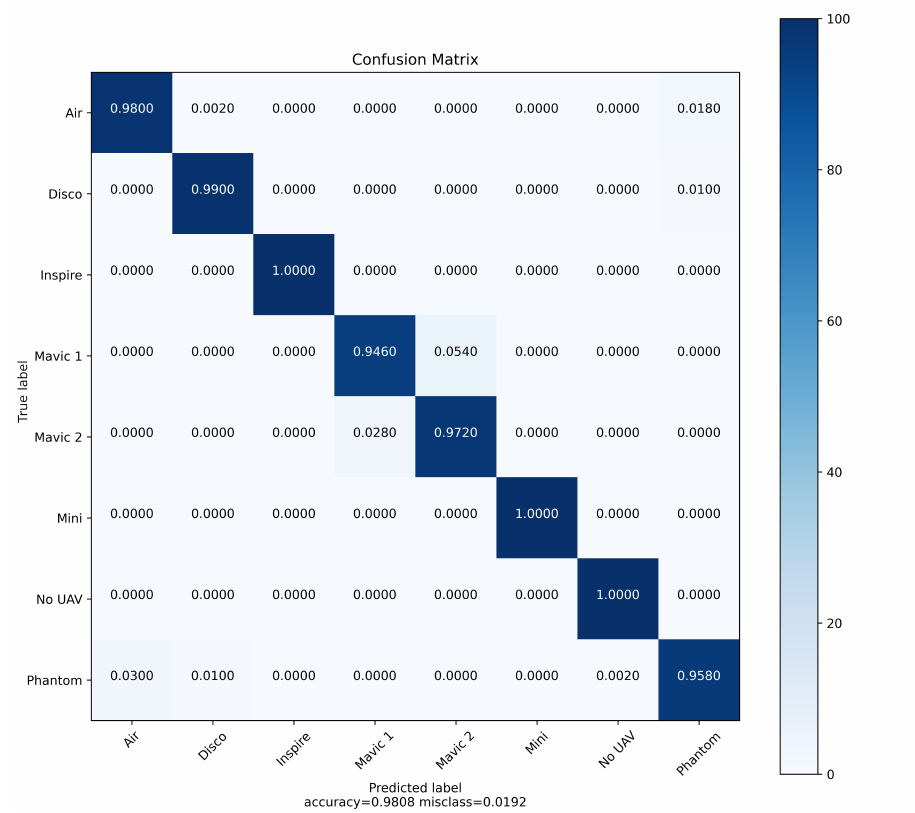
Figure 14. UAS type classification confusion